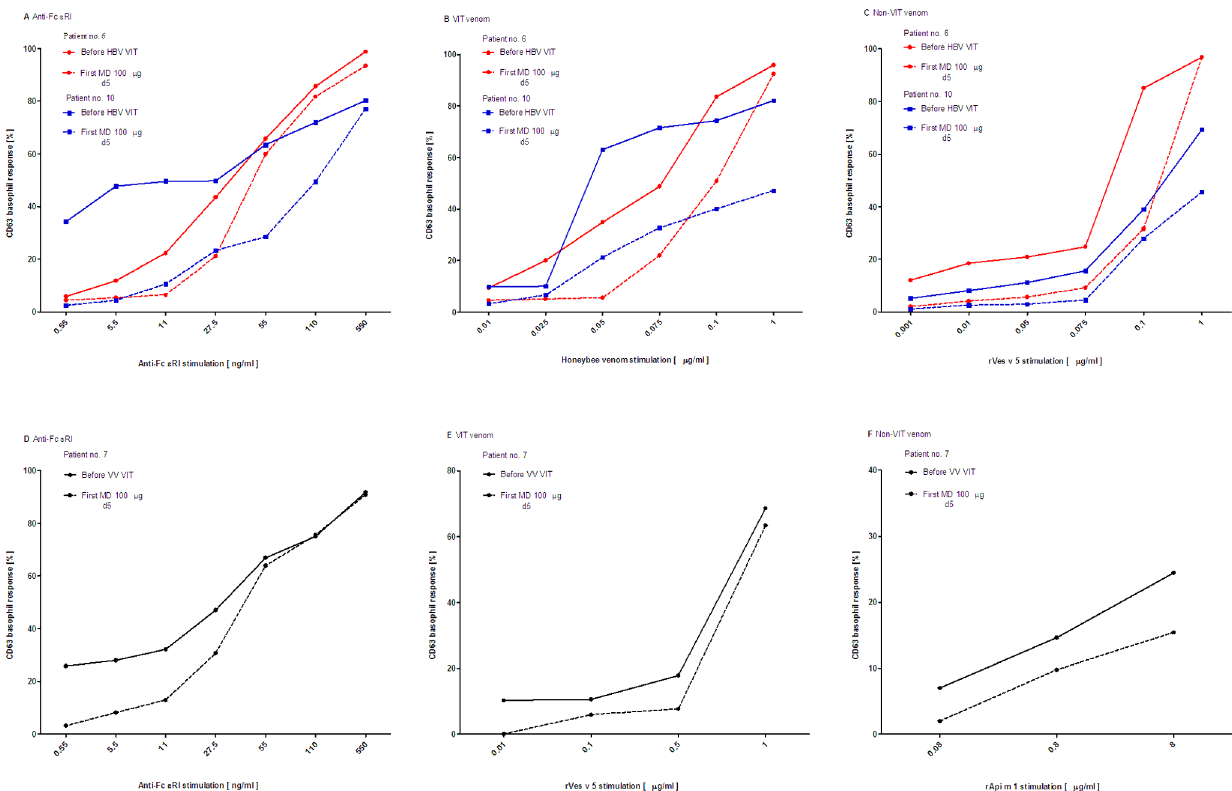
Figure 2. A–F. Basophil response to recombinant species-specific major allergens. CD63 basophil dose-response curves in double positive patients nos. 6 and 10 in A to anti-Fc e RI in B to honeybee and in C to rVes v 5 stimulation before treatment and the first maintenance dose of honeybee ultra-rush VIT and in double positive patient no. 7 in D to anti-Fc e RI in E to rVes v 5 and in F to rApi m 1 stimulation before treatment and the first maintenance dose of Vespula ultra-rush VIT.